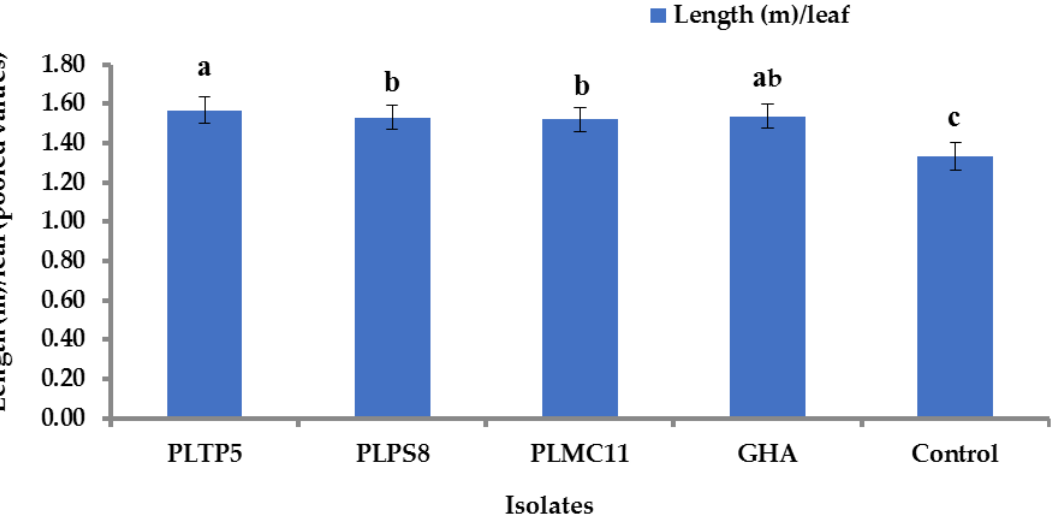
Figure 9. Effect of EPF conidia formulation application on the leaf length of sugarcane. Different letters (a–c) in columns indicate significant differences ( p ≤ 0.05) among the isolates. Columns represent the mean ± SD ( n = 3). SD = standard deviation.